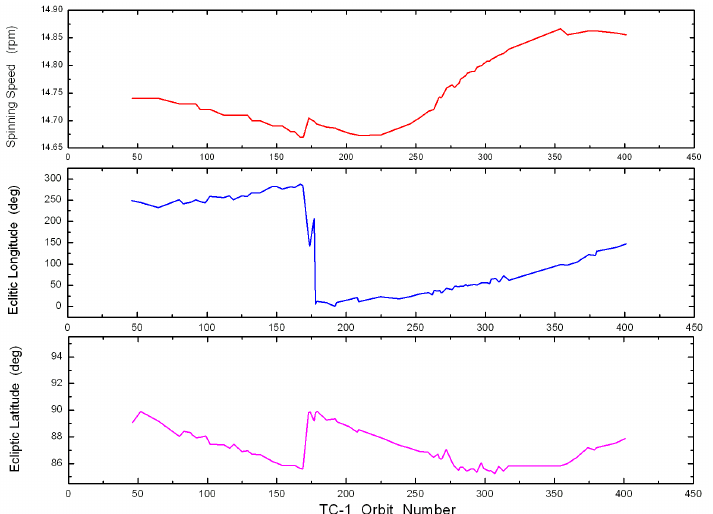
Fig. 2. Evolution of the magnetic local time (left panel) and SM latitude (right panel) of the apogee of DSP with time as predicted. The origin of the horizontal axis is the launch time of TC-1.